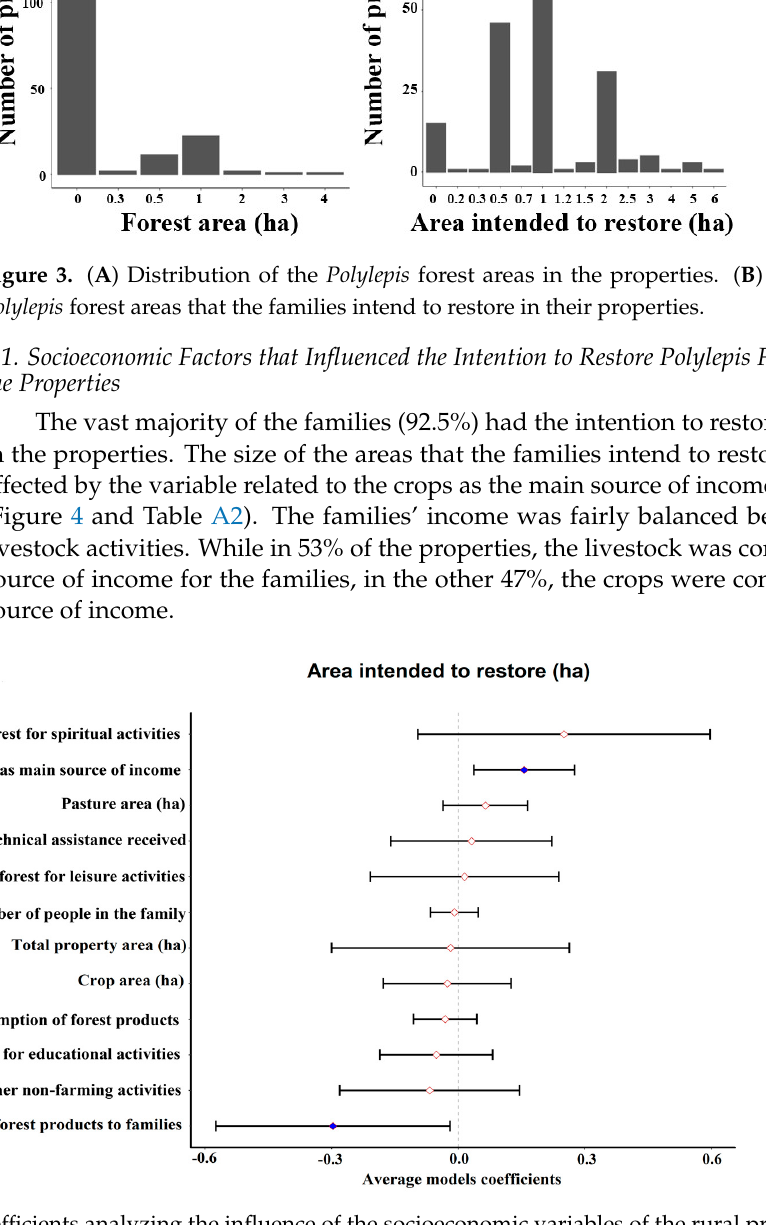
Figure 4. Average models coefficients analyzing the influence of the socioeconomic variables of the rural properties in the size of the Polylepis forest areas that the families intend to restore.